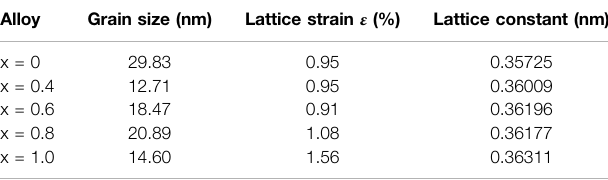
TABLE 3 | Average grain sizes, lattice strains and lattice constants of 40 h-milled FeCoNi(CuAl) x MEA and HEA